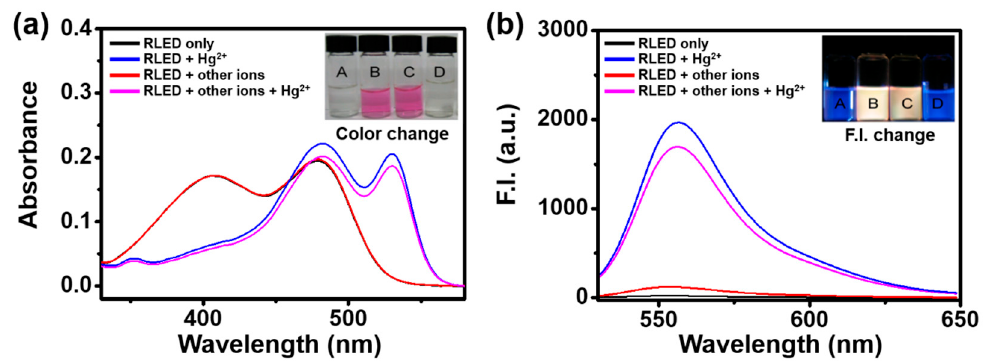
Figure 2. ( a ) Absorbance spectra of RLED (10 µ M) in MeOH/HEPES (pH 7.4; 1/9; v / v ) at 25 ◦ C upon the addition of 1 equivalent of Hg 2+ and other metal ions, including Cu 2+ , Zn 2+ , Pb 2+ , Cd 2+ , Fe 2+ , Co 2+ , Ni 2+ , Ag + , Na + , K + , Ca 2+ , and Mg 2+ (each 1 equivalent) (inset: color change; A: RLED only; B: RLED + Hg 2+ ; C: RLED + X + Hg 2+ ; D: RLED + X; X denotes miscellaneous ions, including Cu 2+ , Zn 2+